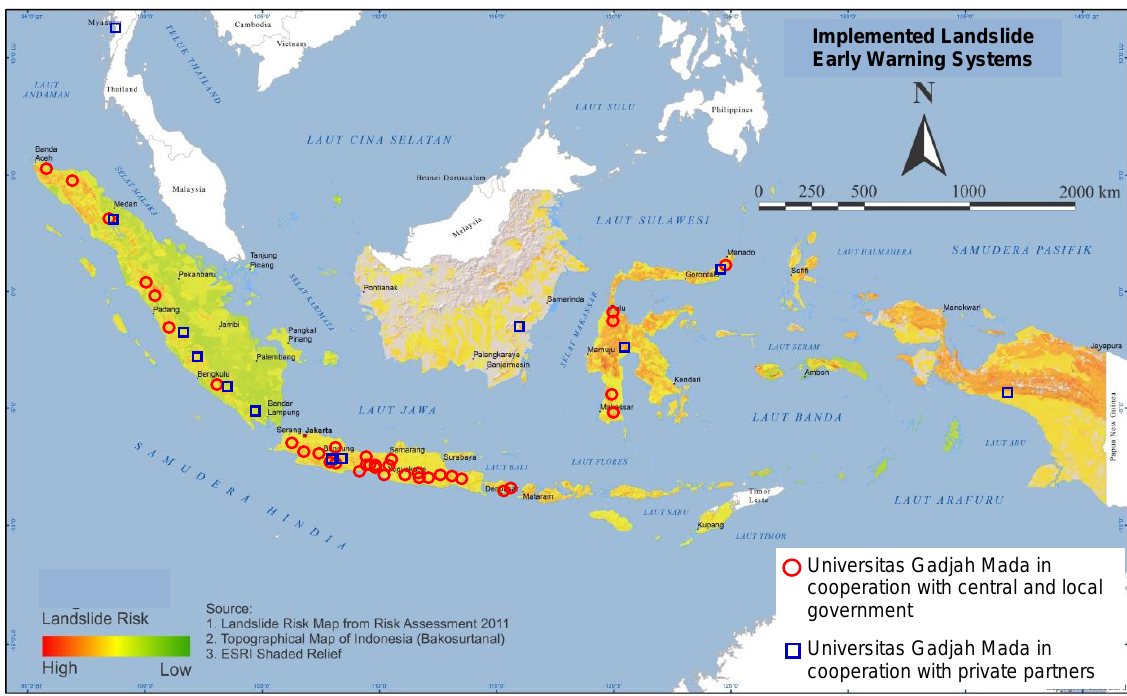
Figure 3. The implementation of the new standard plotted on the Indonesian landslide risk map (BNPB, 2011). Figure 3: The implementation of the new standard plotted on Indonesian Landslide Risk Map (BNPB, 2010). 5